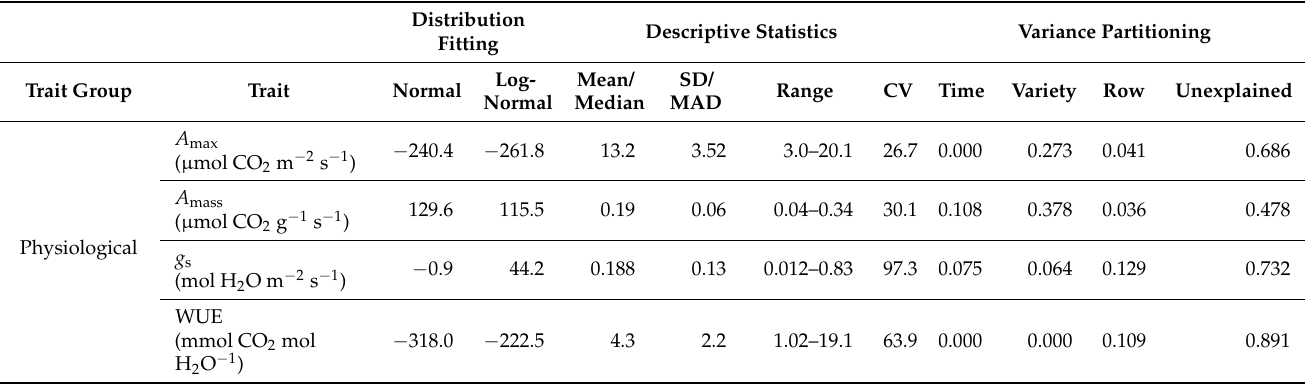
Table 1. Descriptive statistics for nine leaf functional traits measured across five grape varieties at two different growth